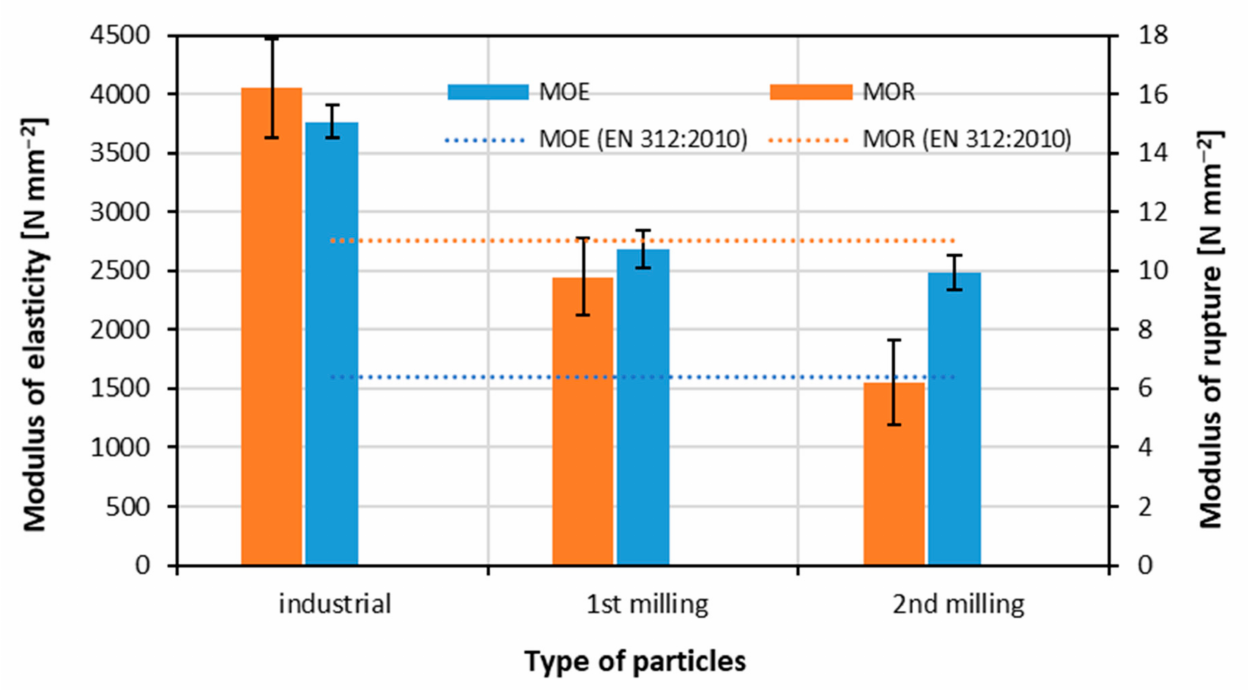
Figure 3. Modulus of elasticity and modulus of rupture of the panels produced by using different